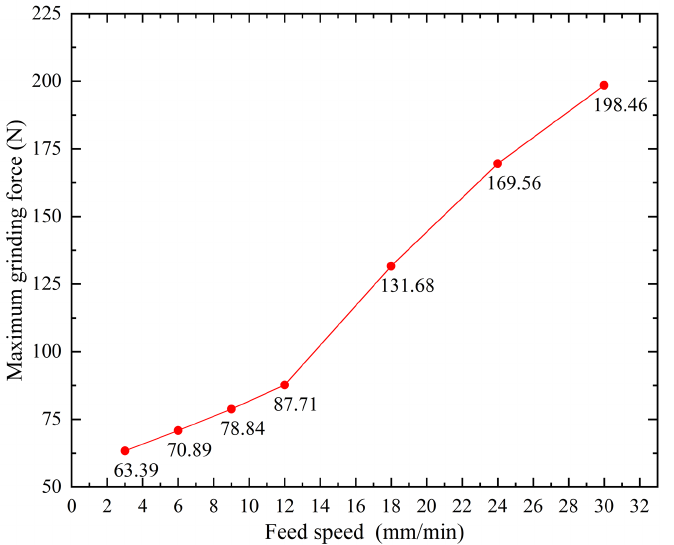
Figure 7. Variation curve of maximum grinding force under the certain feed speed.